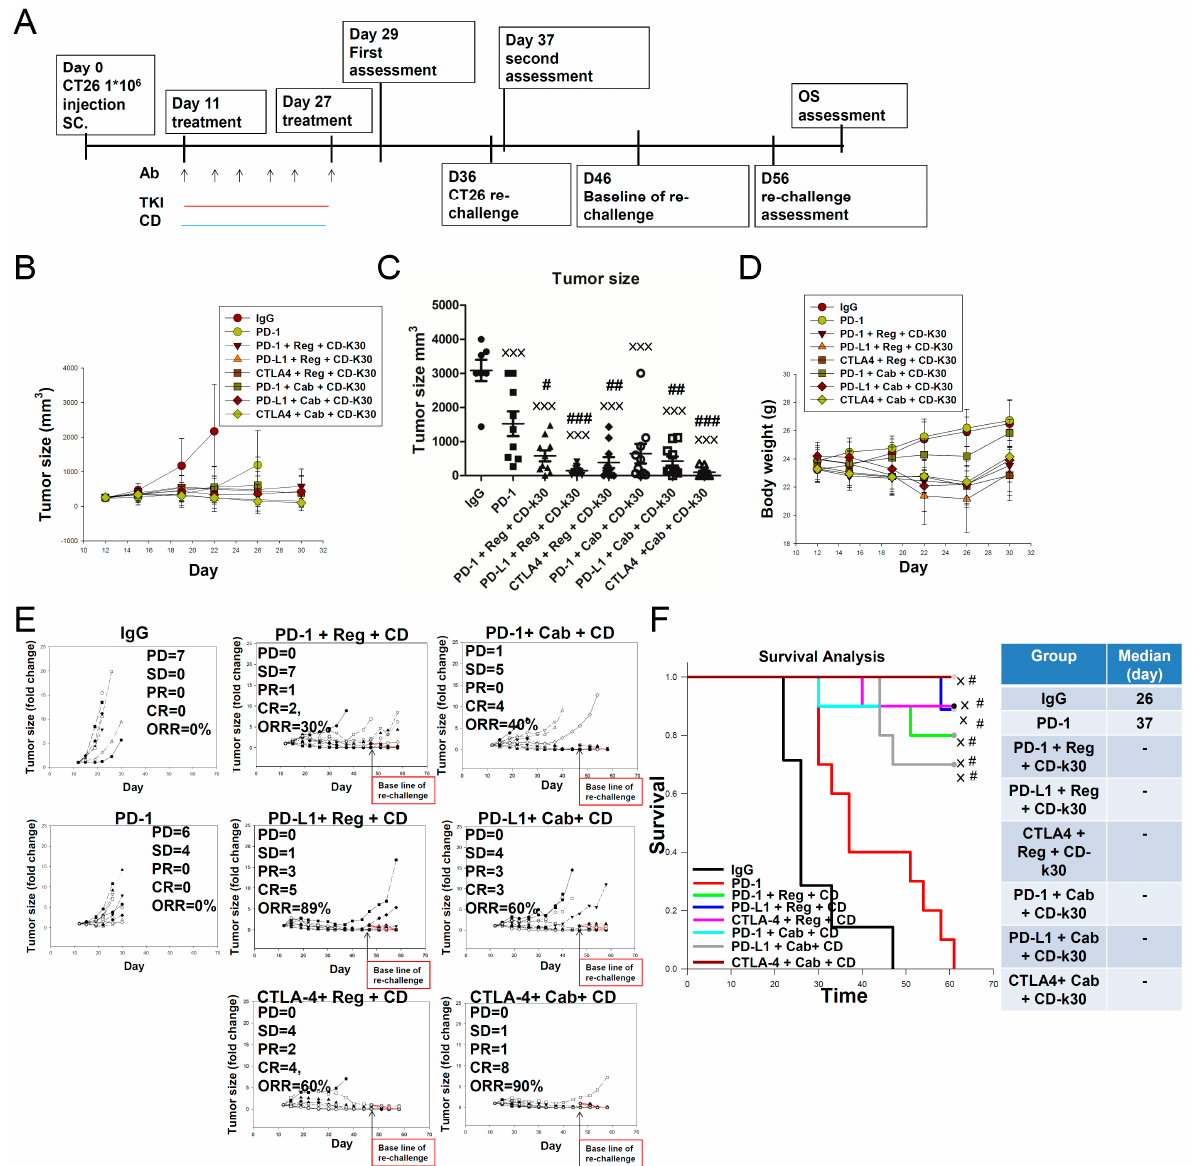
Figure 4. ( A – F ) shows the results of therapeutic responses and immunity evaluations of different ICIs combined with Cabozantinib or Regorafenib plus Chidamide-k30 in CT26 tumor-bearing mice. Balb/c mice bearing a CT26 tumor were treated with various therapeutic modalities as indicated. The combination therapy is shown in ( A ) consecutive treatment schedule and ( B ) total tumor volumes. ( C ) Endpoint evaluated tumor volumes at D26. ( D ) Mice body weights. ( E ) Individual tumor volumes. ( F ) Animal survival rates. CT26 tumor-bearing mice were treated as indicated and euthanized at a tumor volume of 3000 mm 3 after tumor implantation. After 16-day treatment followed by tumor assessment, the mice with CR and PR response were re-inoculated with CT-26 cancer cells into the opposite flank in a rechallenge experiment. Red line squares indicates re-inoculated CT26 tumor growth in rechallenge experiment. Data are given as mean ± SD; × p < 0.05, ××× p < 0.001 compared to IgG; #, compared to PD-1; one-way ANOVA with Tukey’s test. ( n = 7–10).